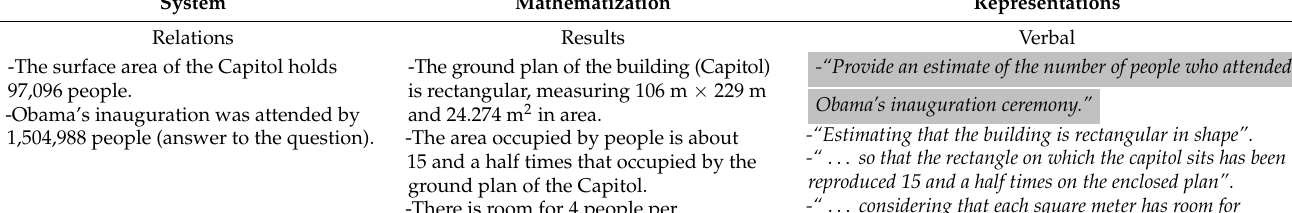
Table 3. Analysis of the written production for the task “the President’s supporters.” The elements shaded in gray were explicitly provided in the statement of the task (source: prepared by the authors).